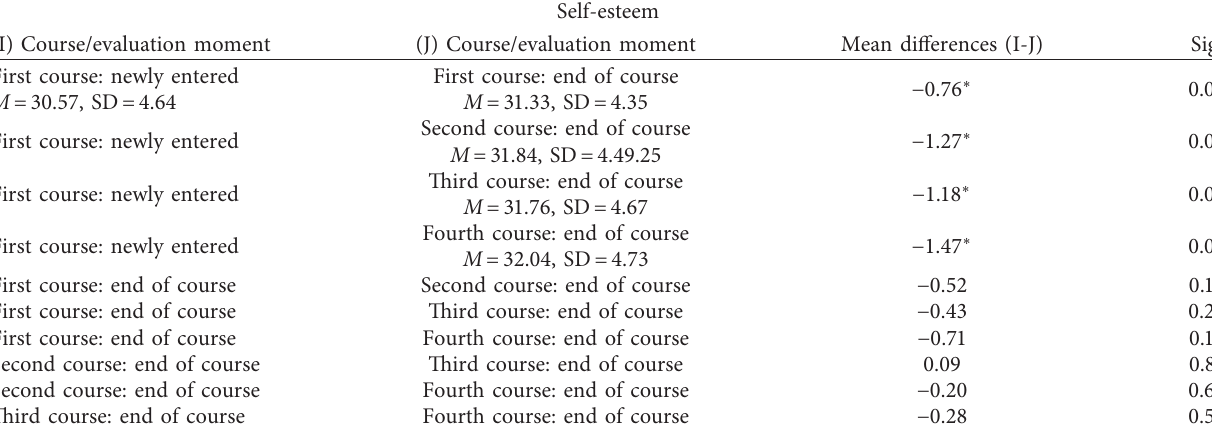
Table 3: Descriptive and post hoc tests (MSD) of differences in self-esteem according to the academic course. Self-esteem